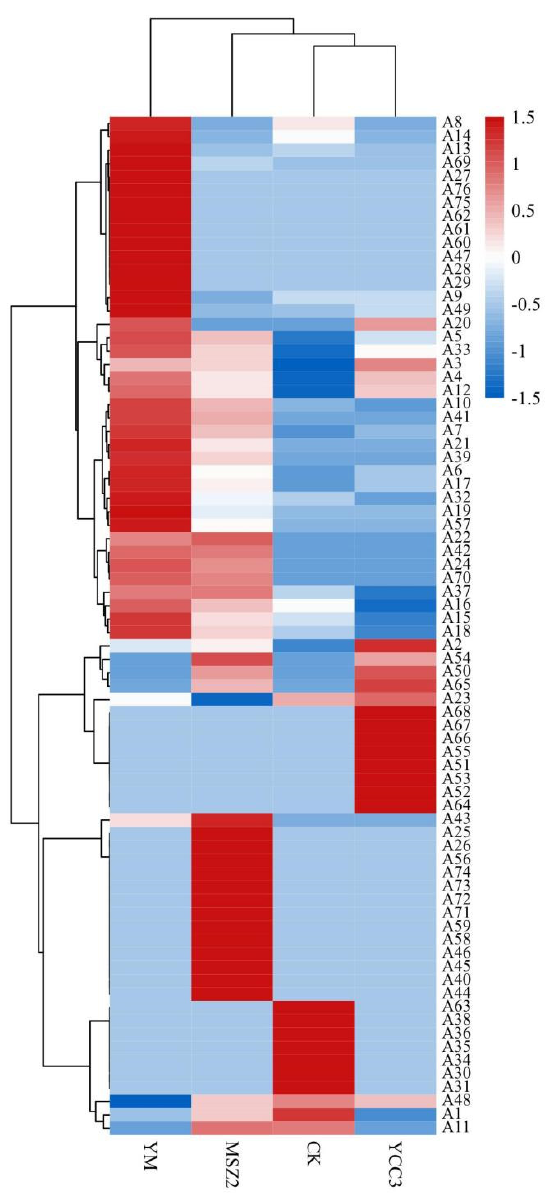
Figure 4. Heatmap of volatile flavor compounds in fermented sausage. The colors correspond to normalized mean levels from high (red) to low (blue).